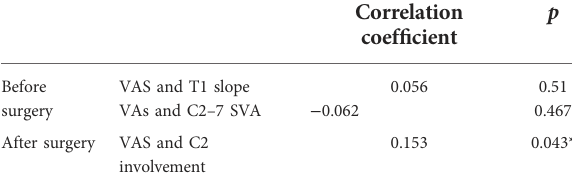
TABLE 5 Correlation between VAS and morphometric and surgical